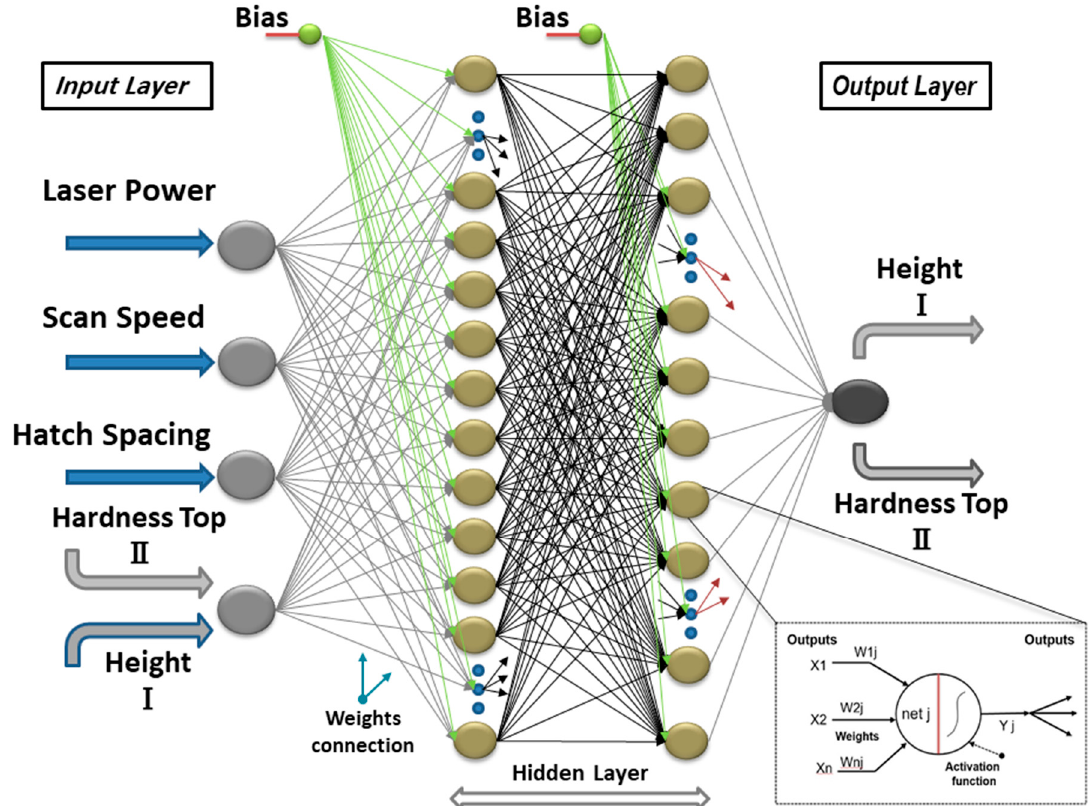
Figure 1. Schematic of the neural network model.